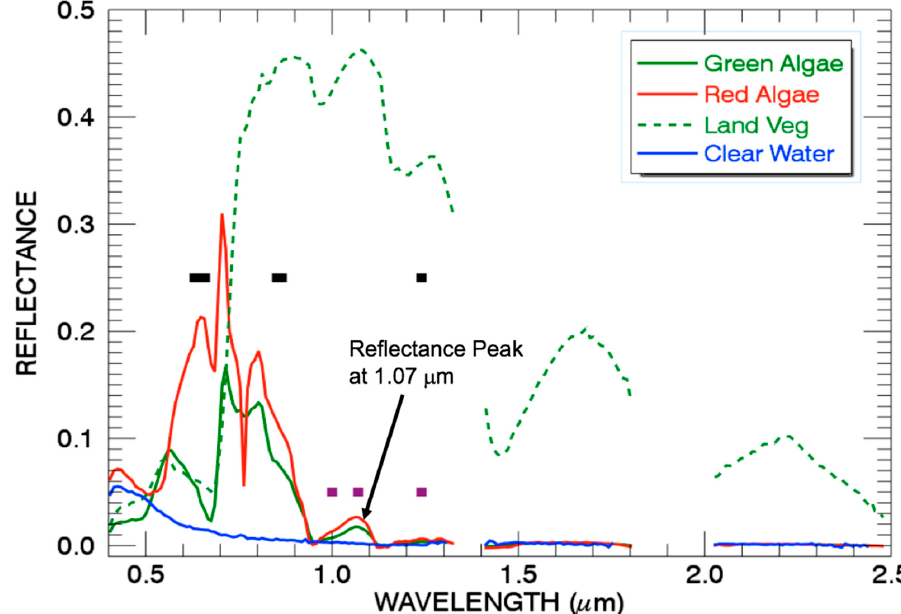
Figure 3. Sample AVIRIS-measured reflectance spectra over pixels covered by floating green algae, red algae, clear water, and green vegetation over land. The positions (1.0, 1.07, and 1.24 µ m) and widths (20 nm) of the three channels proposed for use to form the floating vegetation index (FVI) are illustrated in short thick purple colored bars. In addition, the positions and widths of the MODIS RED, NIR, and SWIR channels used in the formation of MODIS FAI [12] are illustrated in short thick black